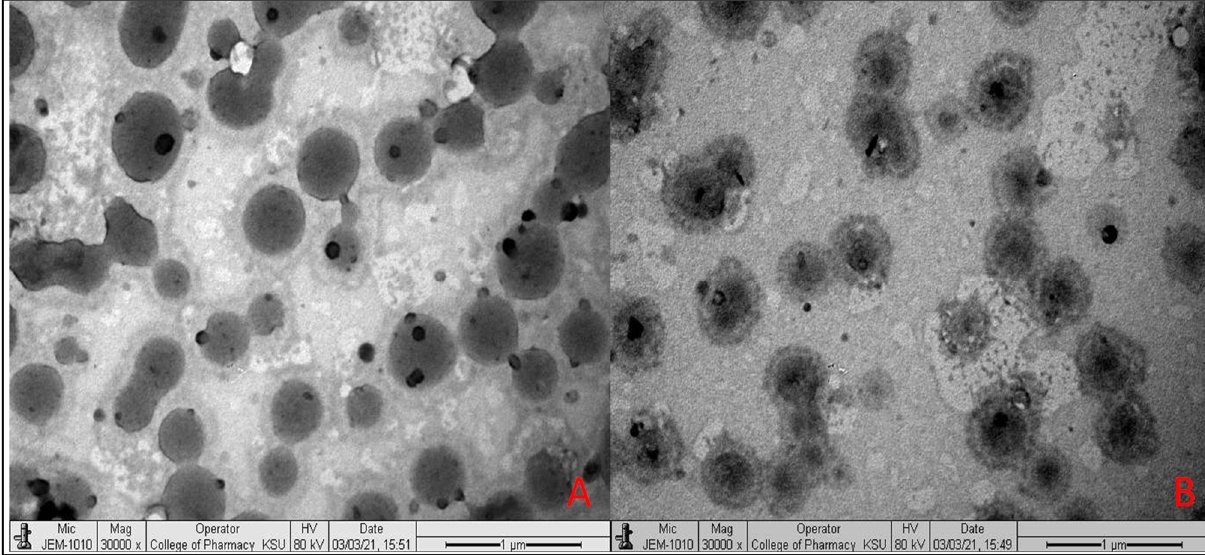
Figure 3. Surface morphology of ( A ). uncoated PPN liposomes (PLF3) and ( B ). chitosan-coated PPN liposomes (PLF3C1).